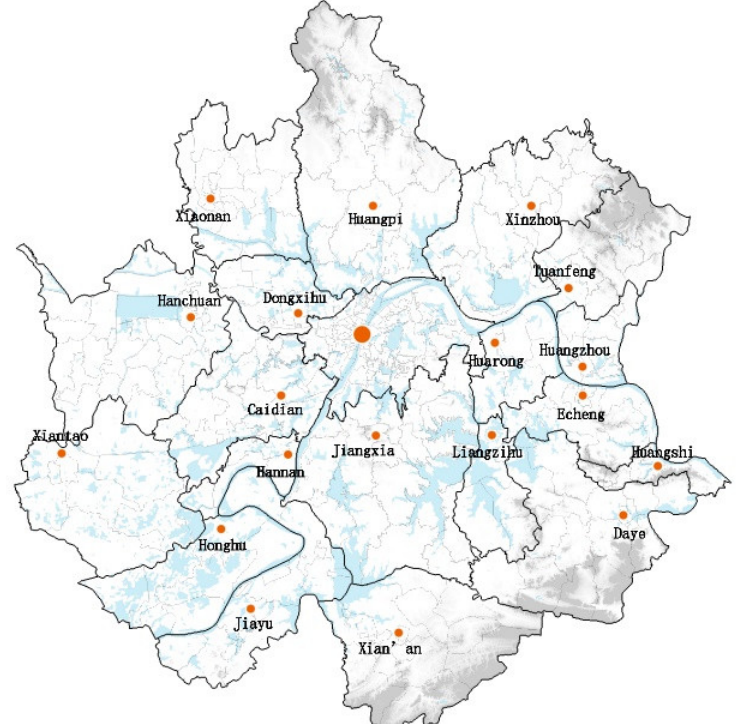
Figure 2. Map of Wuhan metropolitan area.